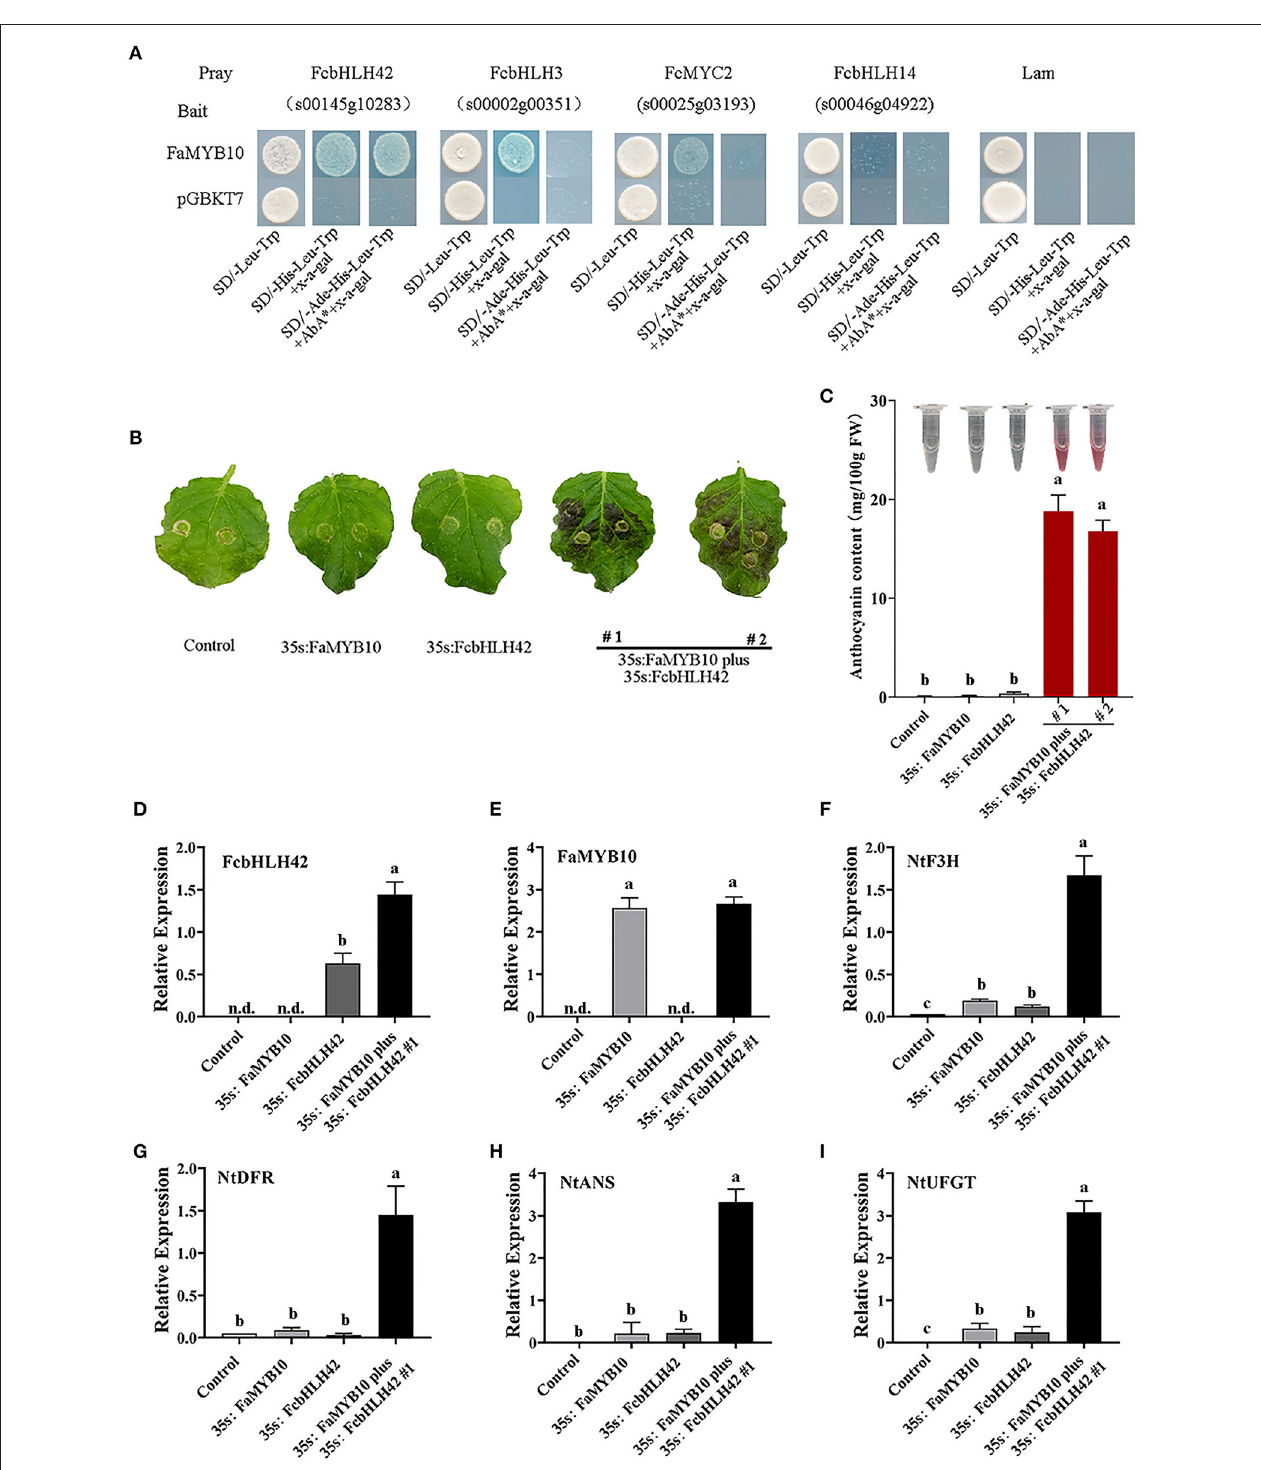
FIGURE 6 | Analysis of FcbHLH interactions with MYB by Y2H and transient overexpression of FcbHLH42 . (A) Y2H tests for four FcbHLHs and FaMYB10 (R2R3–MYB). Interactions of FcbHLH42 (s00145g10283), FcbHLH3 (s00002g00351), FcMYC2 (s00023g03193), FcbHLH14 (s00046g04922), and FaMYB10. (B) Phenotype of tobacco leaves after infiltration. Tobacco ( N. benthamiana ) leaves were infiltrated with cDNA constructs corresponding to FcbHLH42 , FaMYB10 , and agroinfiltration solution (control). 35S: FaMYB10 plus 35S: FcbHLH42 #1 and #2 are two individual plants. (C) Color display after total anthocyanin extraction from the infiltrated tobacco leaves and the anthocyanin content in tobacco leaves after infiltration. (D–I) Expression of FcbHLH , FaMYB10 , NbF3H , NbDFR , NbANS , and NbUFGT in the control, 35S: FaMYB10 , 35S: FcbHLH42, and 35S: FaMYB10 plus 35S: FcbHLH42 #1 tobacco leaves after infiltration; n.d., not detected.